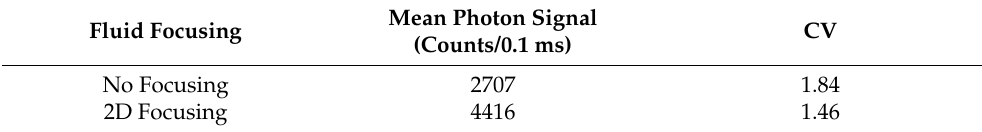
Table 5. Mean and CV for a biosensor illuminated by twenty-micron-wide spot laser. Fluid